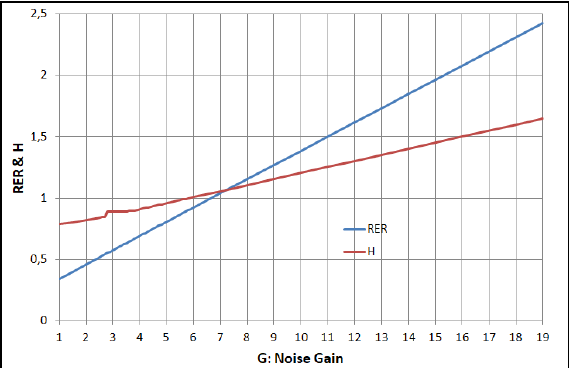
Figure 3: RER and H versus G for Q=1 reference sensor